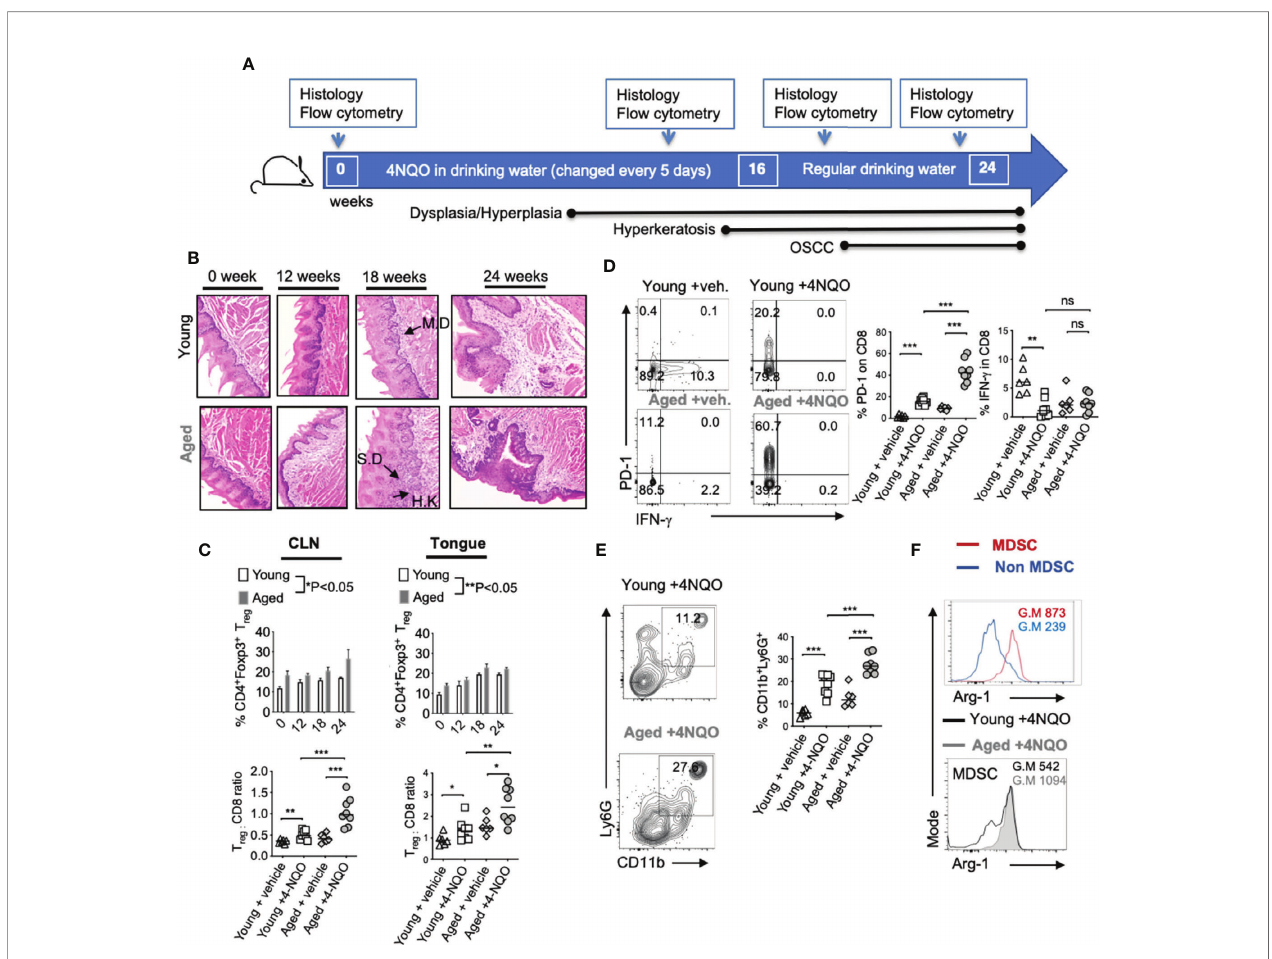
FIGURE 1 | Aged mice display accelerated development of OSCC and heightened levels of immunosuppressive cells in the tongue. 4-NQO was (50 m g/ml) administered in drinking water. Time-points for readouts and various stages of OSCC development in this model are shown (A) . H&E immunohistochemistry images of the tong15ue at 200X magni fi cation at indicated times [IF, In fi ltration; MD, mild dysplasia; SD, severe dysplasia/hyperplasia; HK, Hyperkeratosis]. Samples were processed for fl ow cytometry (B) . Statistics showing %T regs ( C , top) and T reg :CD8 ratio ( C , bottom) in the draining cervical lymph nodes (CLN) (left), or tongue (right) at 16 weeks (D) . Contour plots (left) and statistics (right) showing % of PD-1 and IFN- g expressing CD8 + cells (E) . Representative contour plots (left) and statistics (right) showing % of CD11b and Ly6G expressing CD45 + cells. Arg-1 expression in MDSC (CD45 + CD11b + Ly6G + ) vs non MDSC (CD45 + CD11b + Ly6G -neg ) cells ( F , top) and in MDSC in young and aged 4-NQO treated mice ( F , bottom) (Geometric Mean = G.M) (Mann-Whitney test *P < 0.05, **P < 0.05, ***P < 0.005; n.s, non-signi fi